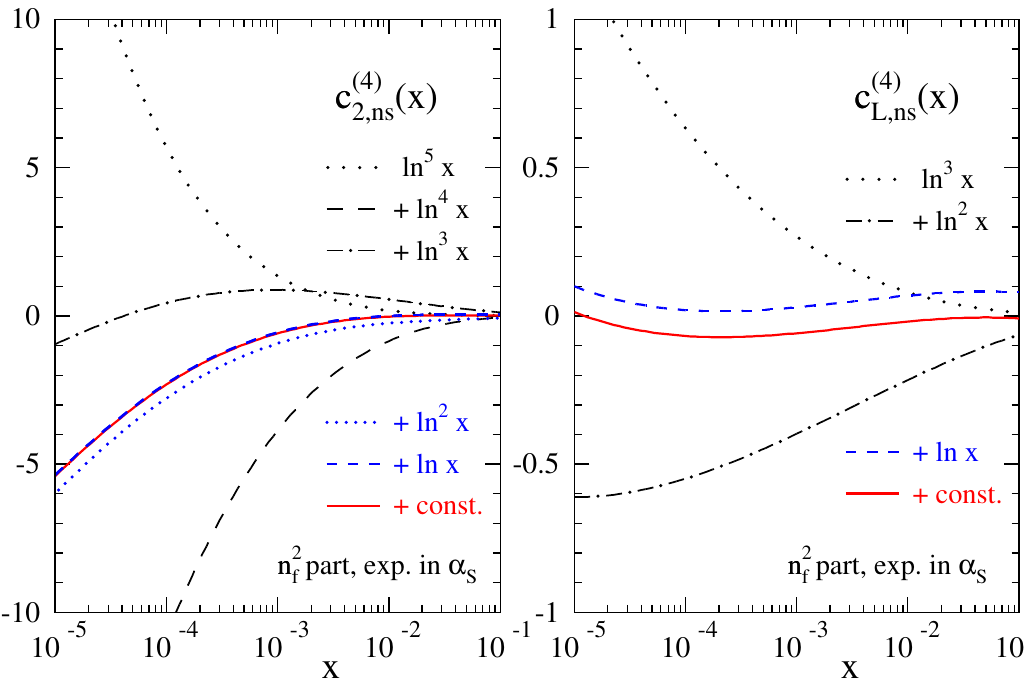
Figure 5 . Successive small- x approximations for the n 2 functions for F 2 , ns (left panel) and F L, ns (right panel). The coefficients in eqs. (5.42) and (5.43) have been converted to an expansion in α s